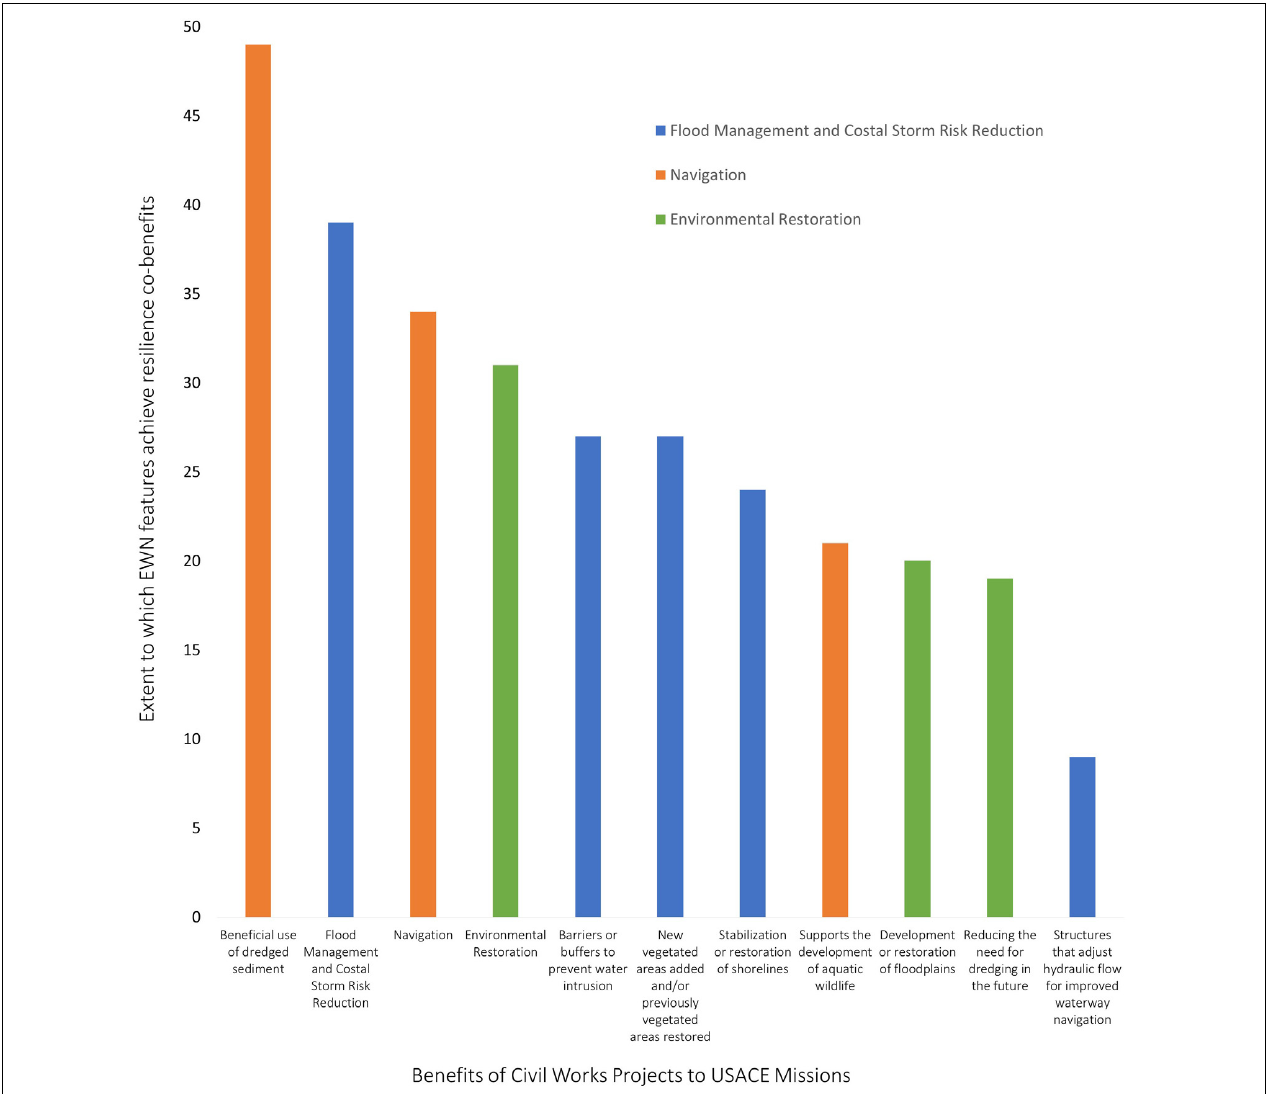
FIGURE 2 | Pairwise comparison of features with resilience benefits by business line